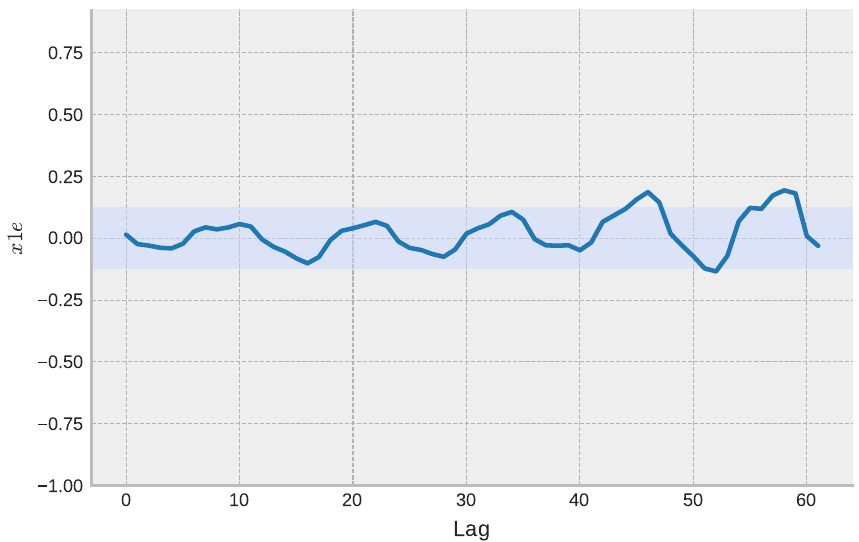
Figure 11. Cross-correlation between the residuals and the